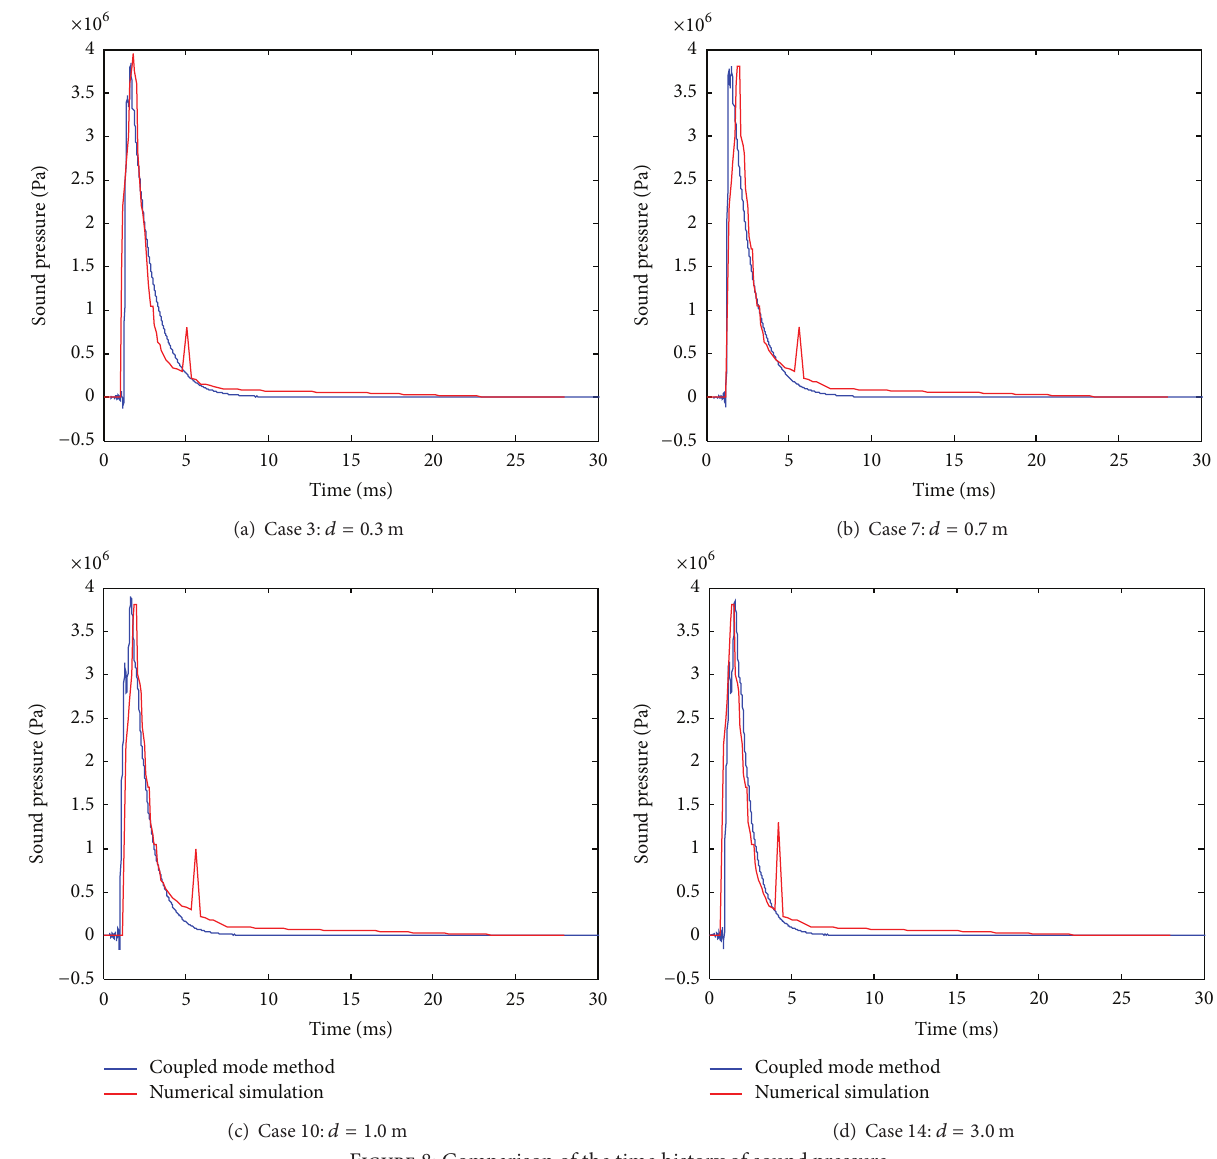
Figure 8: Comparison of the time history of sound pressure. Table 3: Acceleration peak values of cylindrical shells in different